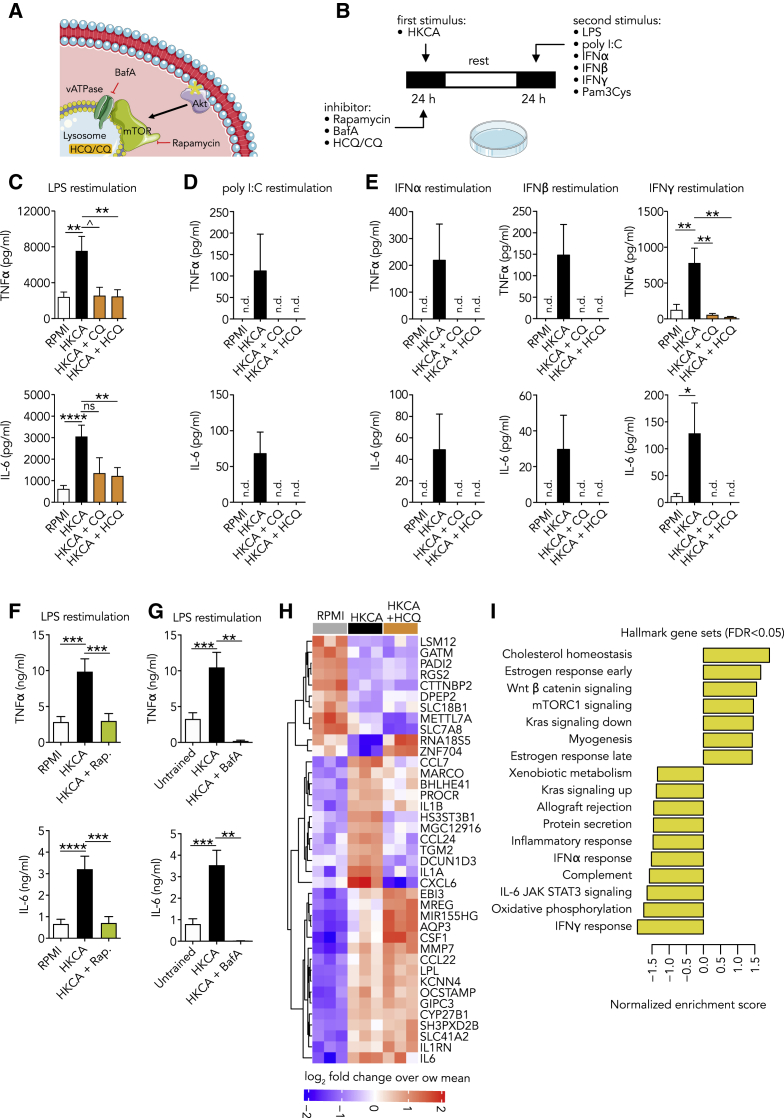
Hydroxychloroquine (HCQ) Prevents the Induction of Trained Immunity(A) Schematic representation of the interaction between the lysosome and the AKT/mTOR signaling pathway.(B) Schematic representation of the trained immunity assay.(C–E) PBMCs were stimulated for 24 h with HKCA with or without specified inhibitors or RPMI as a control. After a 5-day resting period, cells were restimulated for 24 h, and cytokine production was measured in the supernatant.(C) HCQ and chloroquine prevent the induction of a trained immune response to LPS (B, n = 7–17).(D and E) HCQ and chloroquine prevent the induction of a trained immune response to poly I:C (D, n = 5), IFNα (E, n = 5), IFNβ (E, n = 5), and IFNγ (E, n = 5-8, n.d., not detectable).(F) mTOR inhibition prevents the induction of a trained immunity response to LPS (n = 11).(G) Inhibiting lysosome acidification with bafilomycin A prevents the induction of a trained immune response to LPS (n = 4–9).(H and I) PBMCs were stimulated with HKCA, HKCA+HCQ, or RPMI as a control for 24 h. Subsequently, monocytes were purified and transcriptome analysis was performed. (n = 3 for each treatment group)(H) Heatmap of most significantly changing genes between HKCA-stimulated and control PBMCs.(I) Pathway analysis of most significant genes identified (FDR, <0.05) between HKCA-treated cells and HKCA+HCQ-treated cells. Normalized enrichment score is shown for HKCA+HCQ and HKCA, with positive values showing pathways upregulated in HKCA and negative values indicating pathways upregulated in HKCA+HCQ.Data are presented as mean ± SEM; ˆp < 0.06, ∗p < 0.05, ∗∗p < 0.01, ∗∗∗p < 0.001; one-way ANOVA with Dunnett’s post-test.